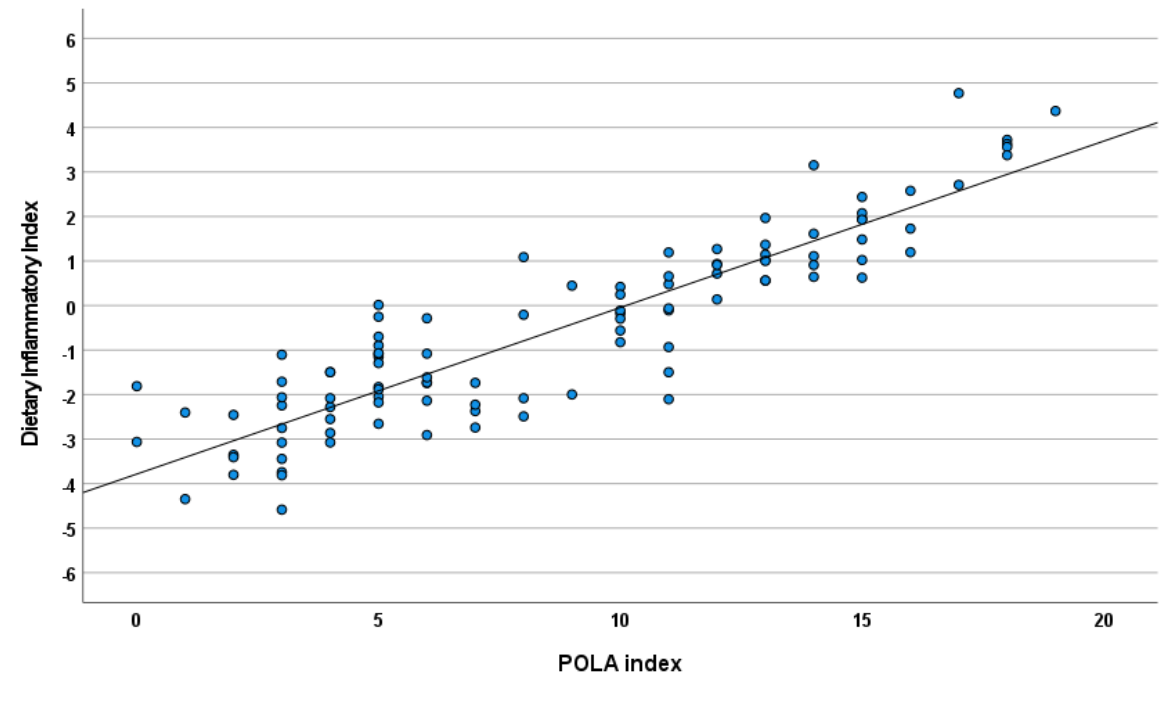
Figure 3. Correlations between the DII and POLA index (r = 0.90; p < 0.0001).